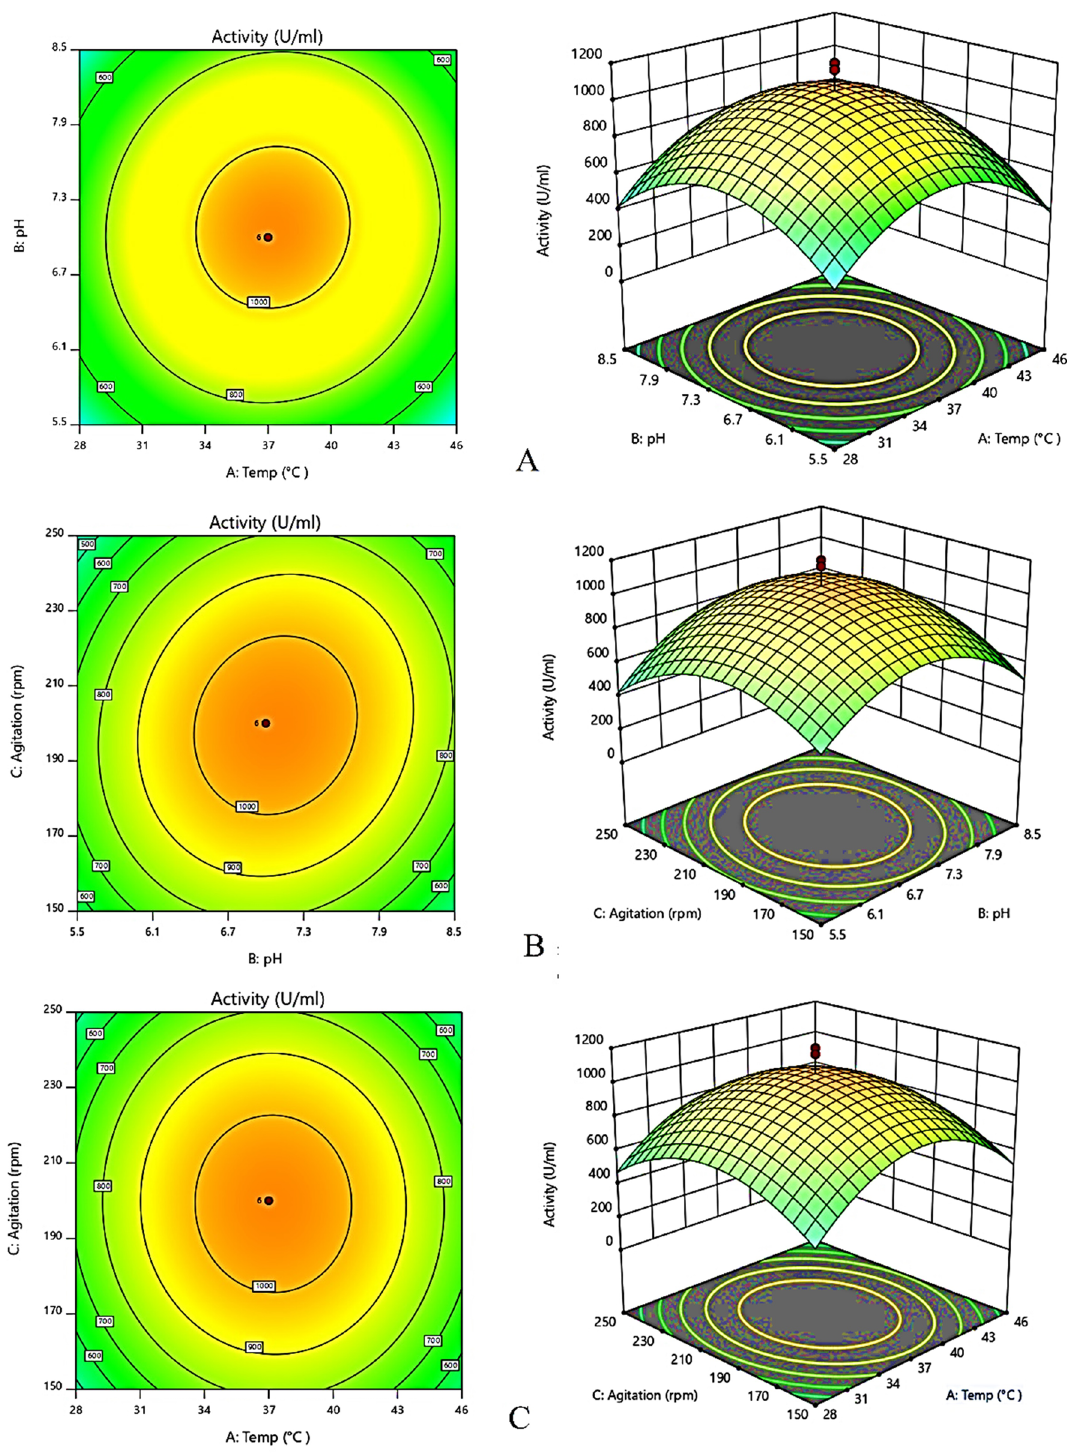
Figure 1. 2D contour plots and 3D response surface plot for recombinant cellulase production depicting interactive effects between ( A ) temperature and pH, ( B ) pH and agitation rate and ( C ) temperature and agitation rate. Design expert version 11 software used from web site: www. state ase.